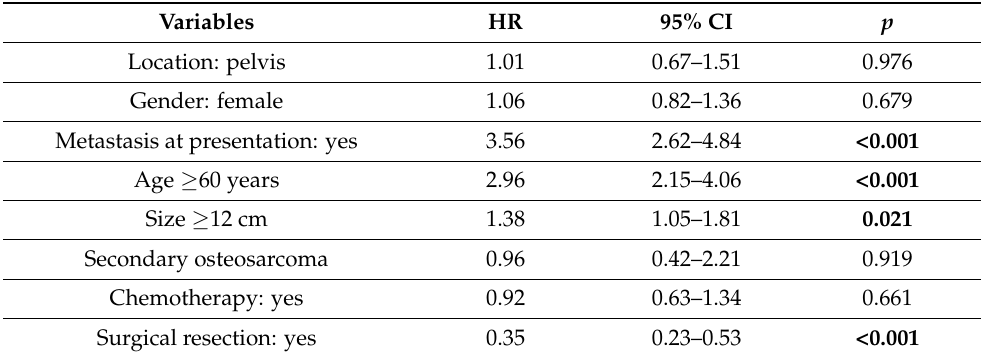
Table 3. Multivariate Cox Hazard models for overall survival of the patients with femoral and pelvic osteosarcoma.